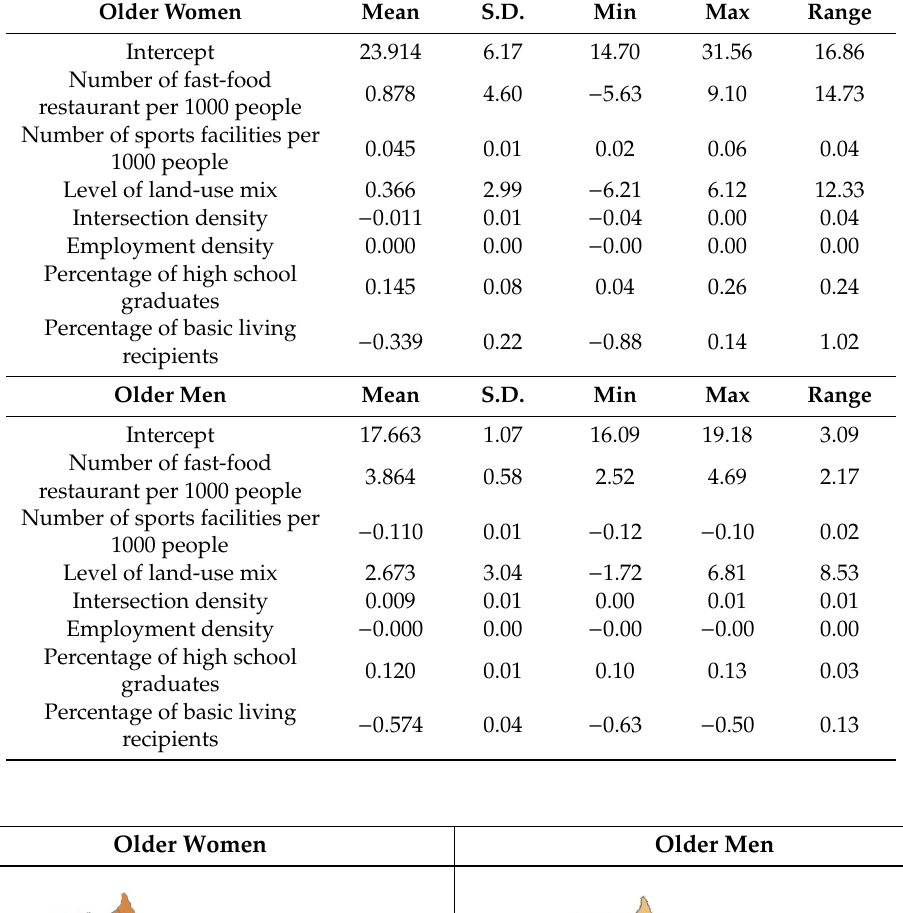
Table 3. Summary statistics of local coe ffi cients in GWR for older men and women.